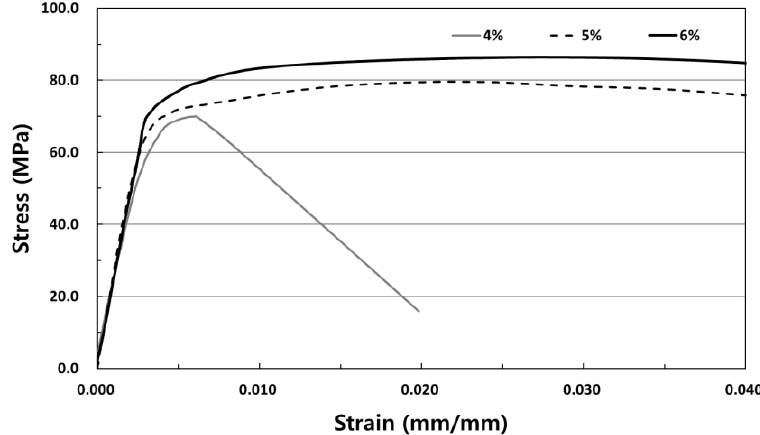
Figure 5. Compressive stress-strain curve with respect to the fiber volume fraction.